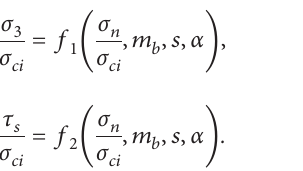
Figure 3: Relationship of instantaneous MC envelope and HB envelope in the normal and shear stress plane.